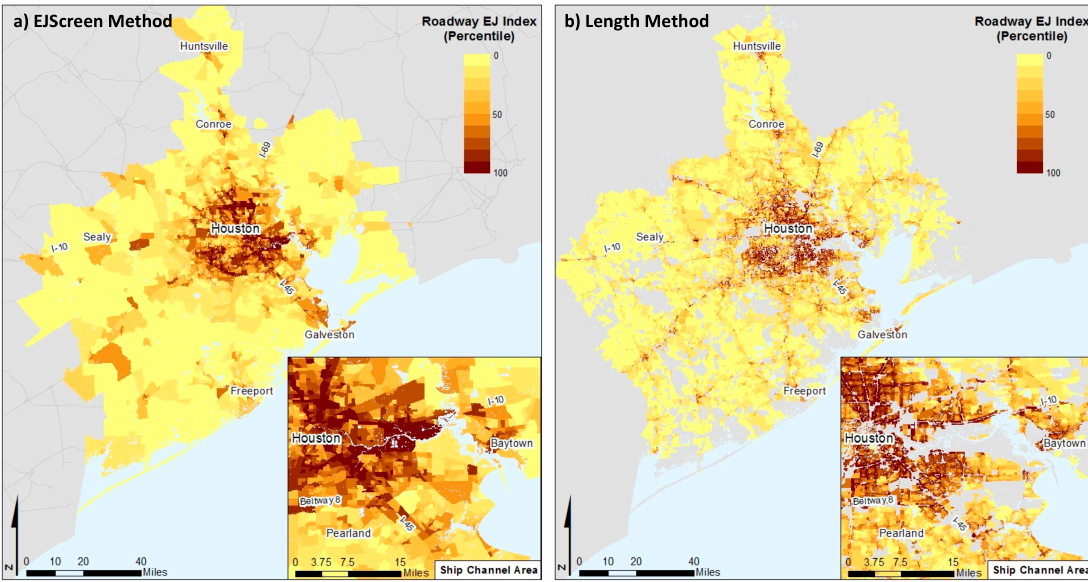
Figure 6. Comparison of Roadway Environmental Justice Indices using the EJScreen and Length Methods. Percentiles are estimated relative to the region.